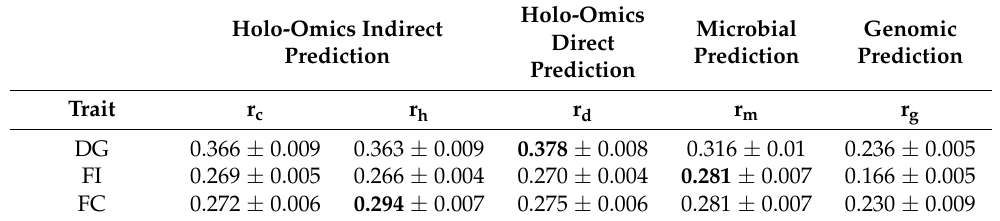
Table 3. Accuracy of holo-omics CORE-GREML (r c ), holo-omics Hadamard (r h ), holo-omics direct (r d ), microbiome (r m ), and genomic prediction (r g ) of gut microbial compositional traits. The best estimated prediction accuracy values are highlighted in bold text. Holo-Omics Indirect